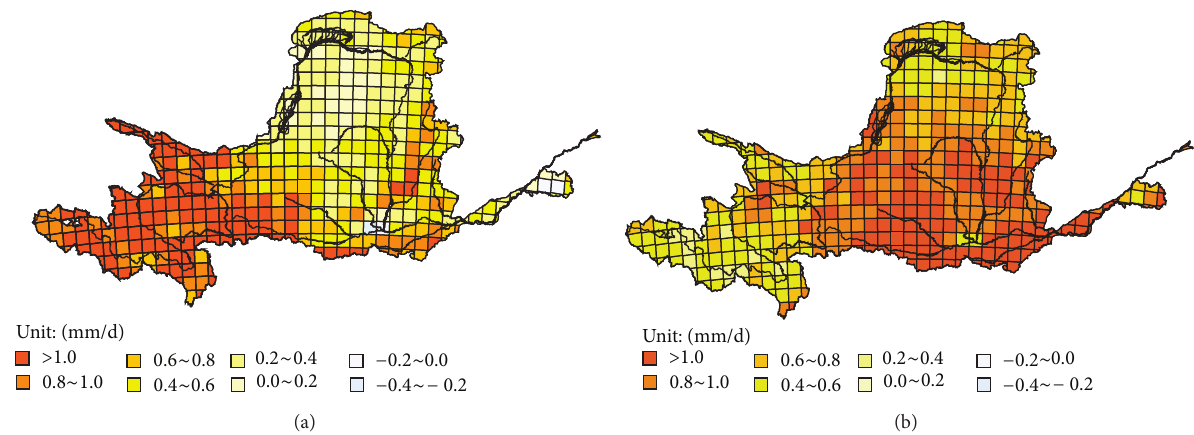
Figure 1: The geographical distributions of bias for precipitation (units: mm/d) between (a) RegCM3 and (b) NCAR and observations, respectively, in the period of 1971–2000.